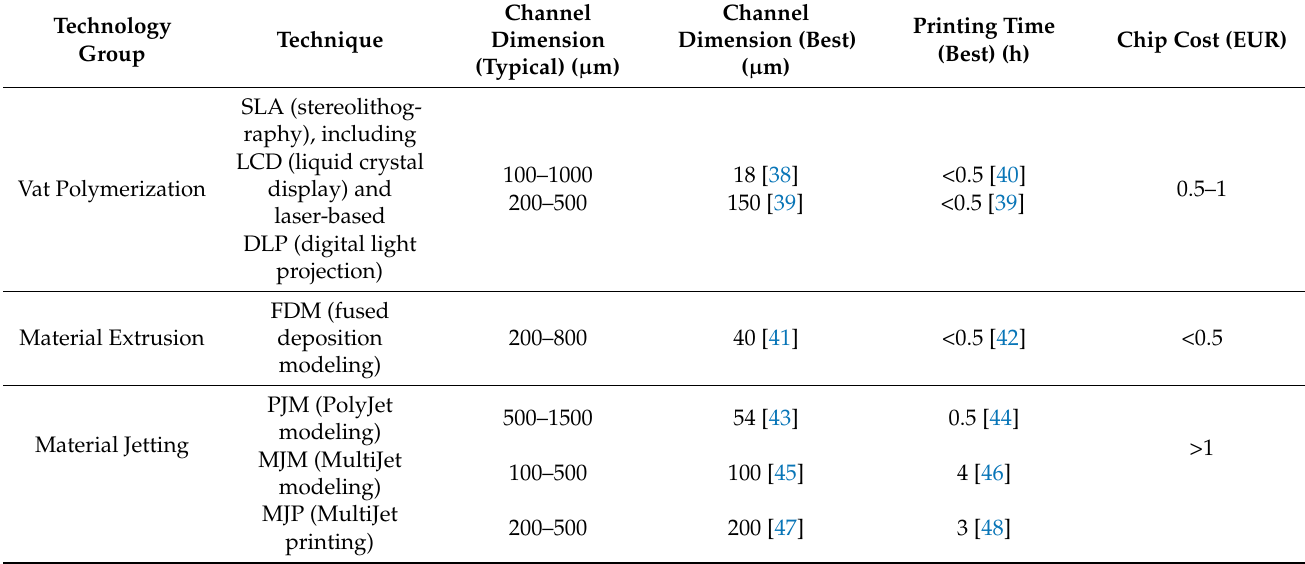
Table 2. Comparison of the most widely used 3D printing techniques and key performance metrics related to printing microfluidics. Based on 106 publications in 3DP microfluidics, SLA offers the best combination of resolution, printing time and cost. FDM offers faster printing times, lower cost and better material selection at the cost of resolution. For specific numbers and paper references, please refer to supplementary material S2. In addition, examples of 3D printing materials and printers used in these papers are shown in Tables S4 and